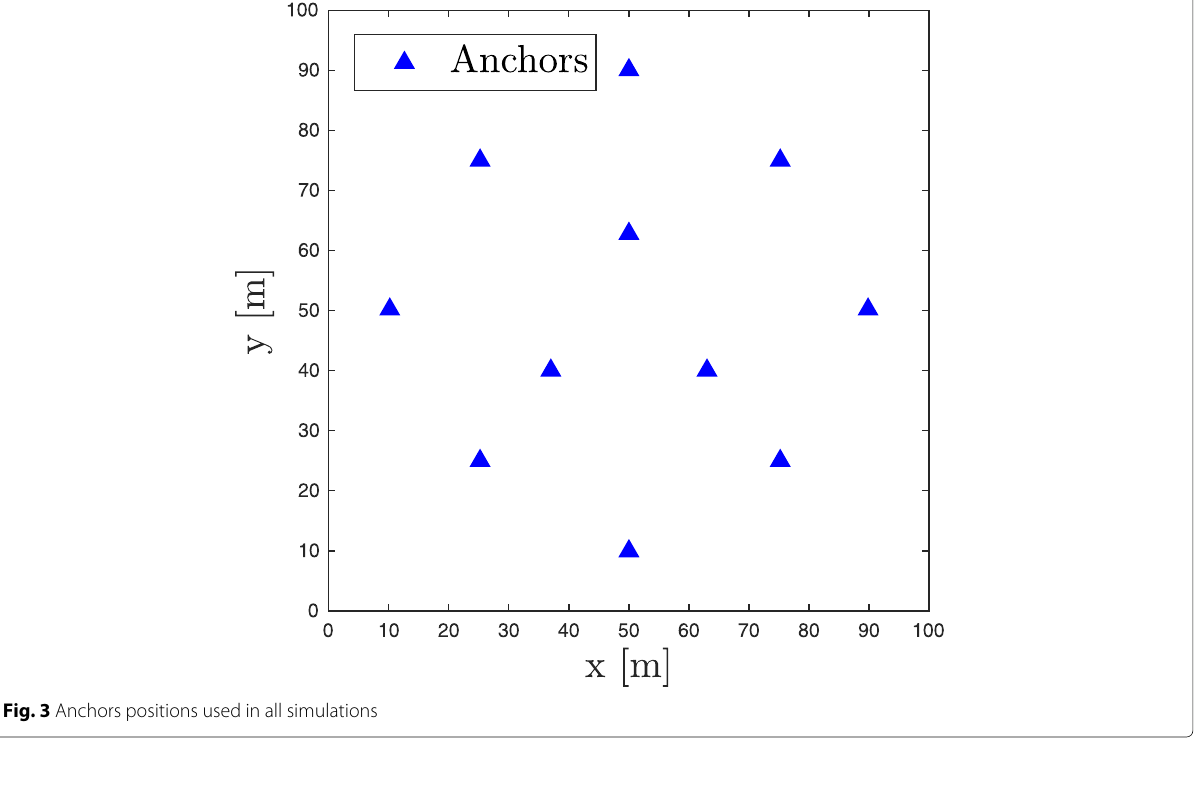
Fig. 3 Anchors positions used in all simulations